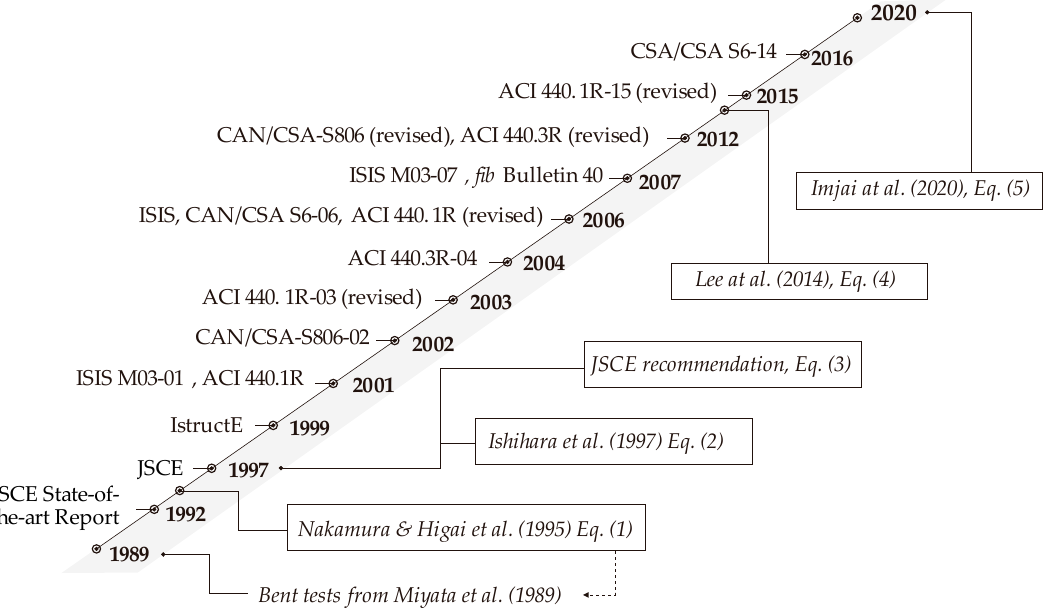
Figure 6. Chronological development of a predictive model for bend capacity and code provisions.